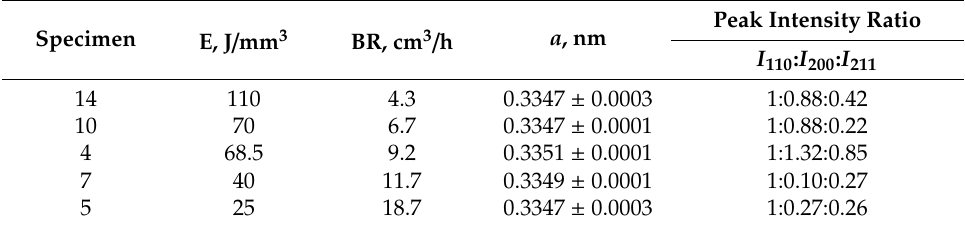
Figure 5. X-ray diffractograms of the selected as-built Ti-18Zr-14Nb samples; increasing power density from top to bottom. Table 4. Beta-phase lattice parameters and X-ray peak intensity ratios of the selected as-built samples presented in decreasing power density order.